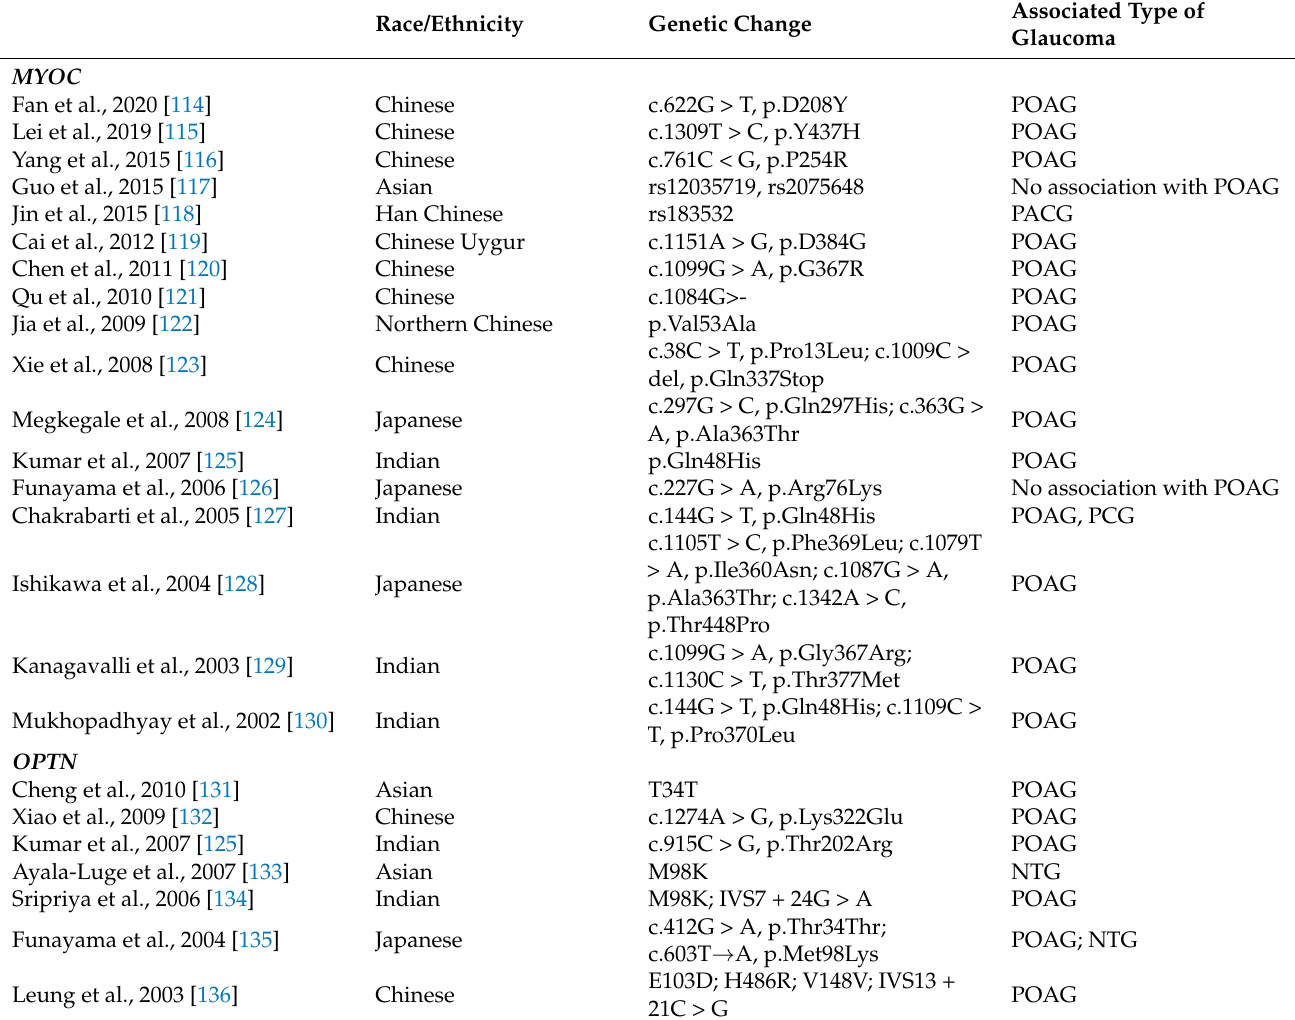
Table 2. Genetic Findings in Adult Asian Populations. NTG: normal-tension glaucoma; PACG: primary angle-closure glaucoma; PCG: primary congenital glaucoma; POAG: primary open-angle glaucoma; HTG: high-tension